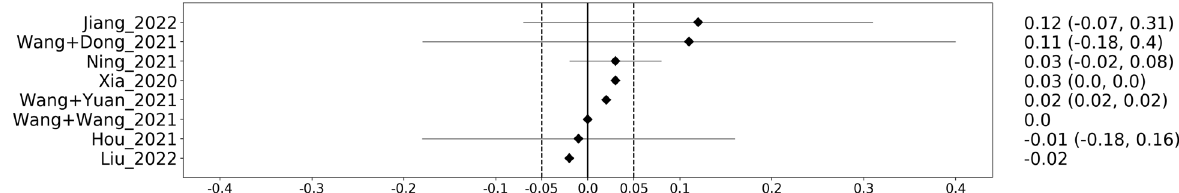
Fig. 7 Graphical display of the performance differences between the fused and the better of generic and deep models on the external validation sets. On the right, the difference in area under the curve together with the 95% confidence interval is given. A positive difference means that the fused model performed better than the deep and the generic